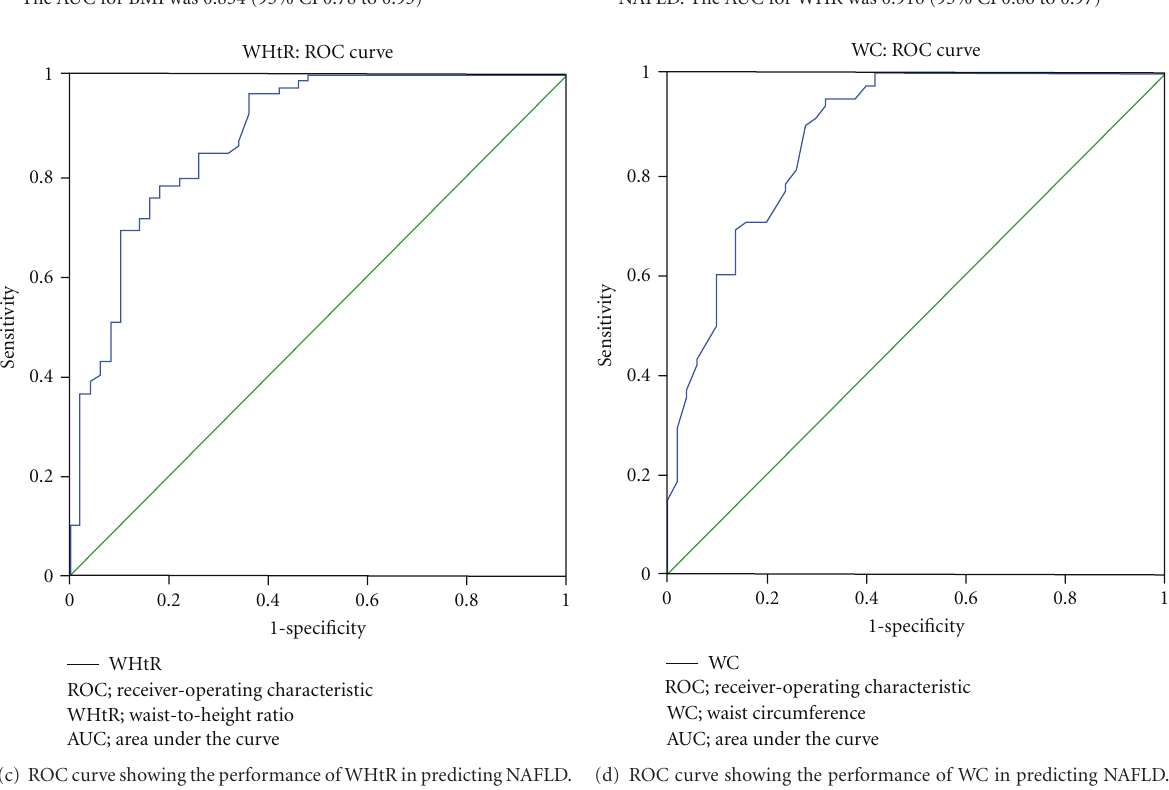
Figure 1: ROC curve analysis of NAFLD-related indicators. (a) BMI; (b) WHR; (c) WHtR; (d)